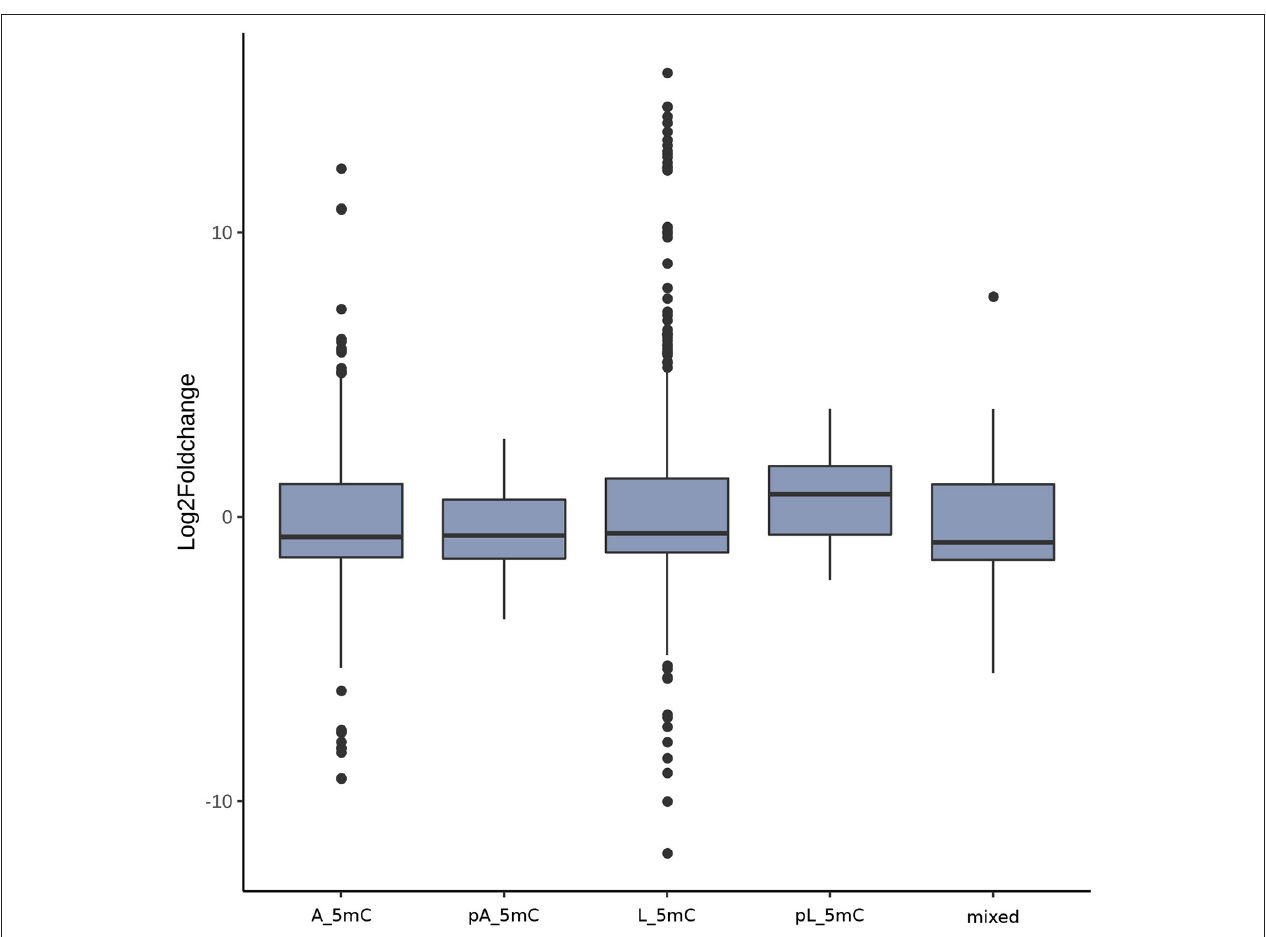
FIGURE 4 | Correlation between gene expression (log2 fold change) and the different possible groups based on methylation status per gene. The methylation status of each gene was defined as mixed, for equal numbers of methylated loci and regions in larvae and adults, as higher methylation in larvae (L_5mC) or higher methylation in adults (A_5mC) where methylation was exclusively state-specific, or as probably higher methylation in larvae (pL_5mC) or probably higher methylation in adults (pA_5mC) for loci/regions methylated in both samples but with a preference for one stage over the